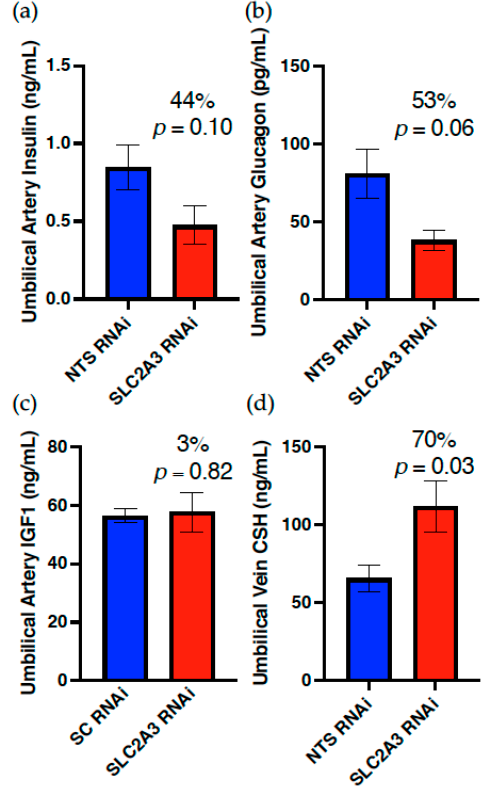
Figure 6. Impact of SLC2A3 RNAi on umbilical artery concentrations of ( a ) insulin, ( b ) glucagon, and ( c ) IGF1, and ( d ) umbilical vein concentrations of CSH. Data are shown as means ± SEM. NTS, non-targeting sequence; RNAi, RNA interference.